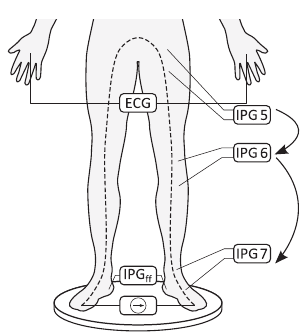
Fig.4: Setup for the foot-to-foot IPG test.